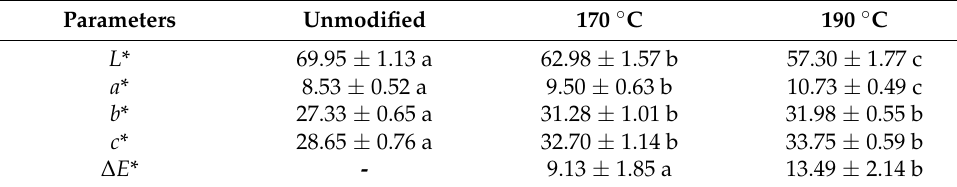
Table 3. Color parameters L *, a *, b *, c *, and ∆ E * of thermally modified Pinus oocarpa .